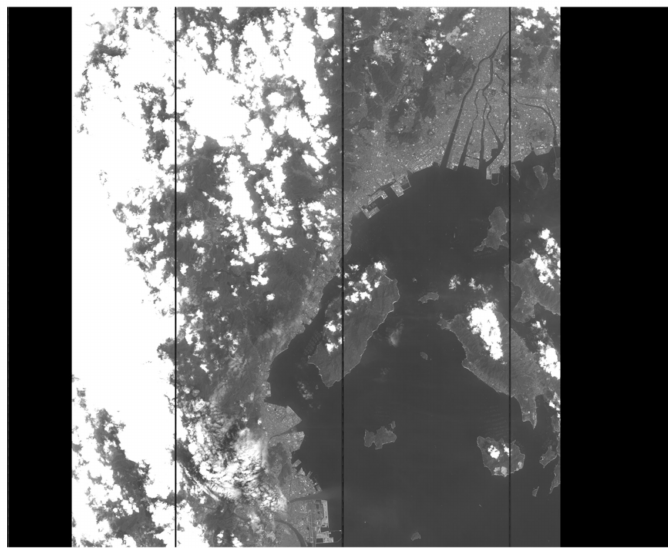
Figure 8. Image data of a typical